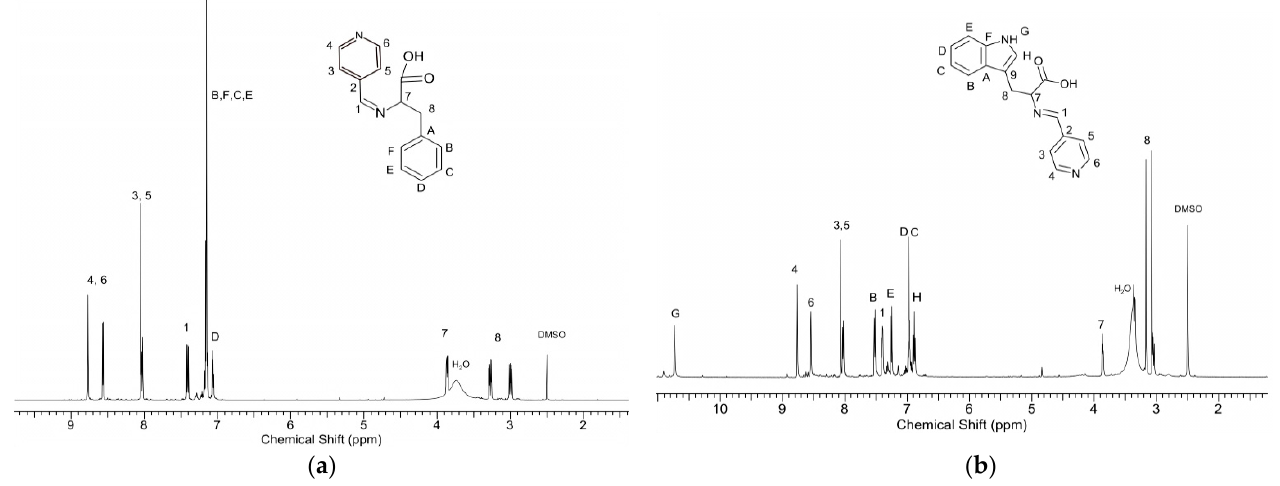
Figure 2. 1 H NMR spectra (in DMSO d 6 ) of the Schiff base; HPhe obtained with L -phenylalanine ( a ), and HTrp obtained with tryptophan ( b ).